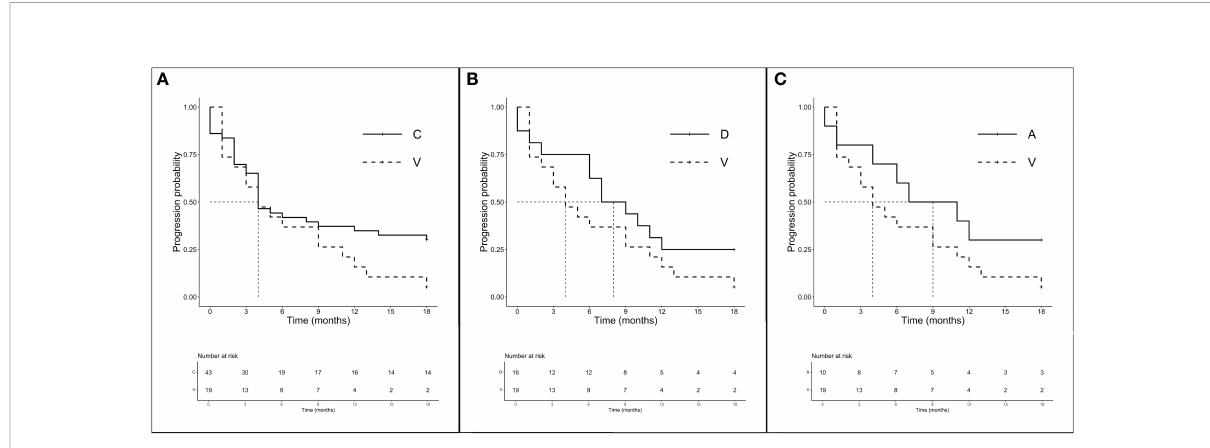
FIGURE 3 PFS according to single amino acid substitutions in patients treated with ICI ± CT ( n = 94). (A) mPFS C ( n = 43) vs . V ( n = 19): 4.0 months (95% CI 4.0 – 18.0 months) vs . 4.0 months (95% CI 3.0 – 12.0 months), p = 0.114. (B) mPFS D ( n = 16) vs . V ( n = 16): 8.0 months (95% CI 6.0 –